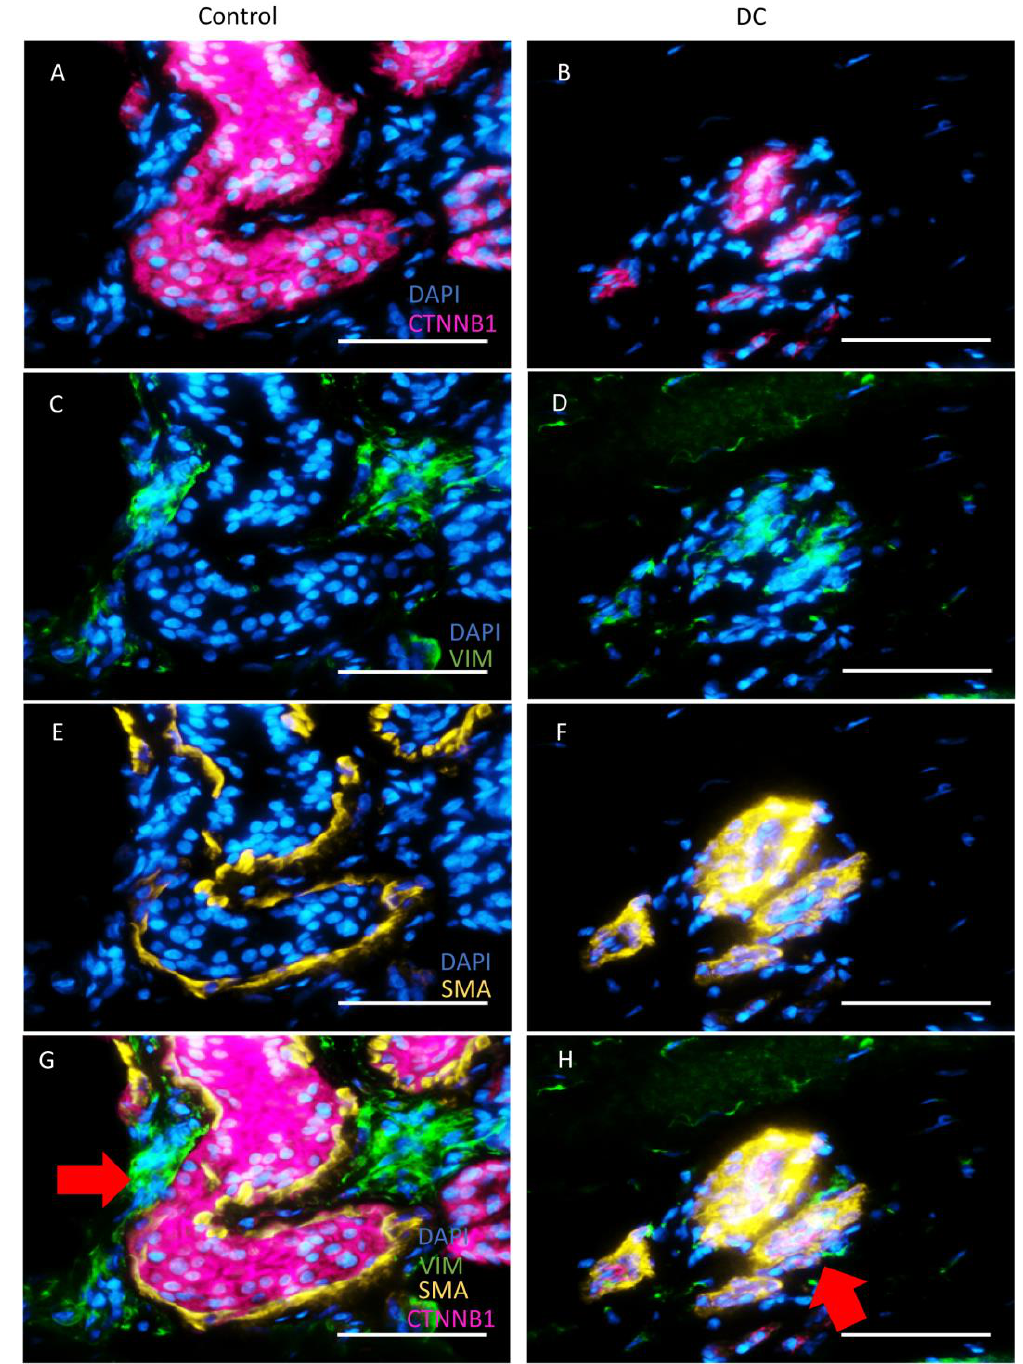
DC samples, and E- cadherin/β -catenin ratio ( S ). The duct in N is marked with a white arrow. Re- sults are presented as mean ± SD and compared to control samples. * p < 0.05.